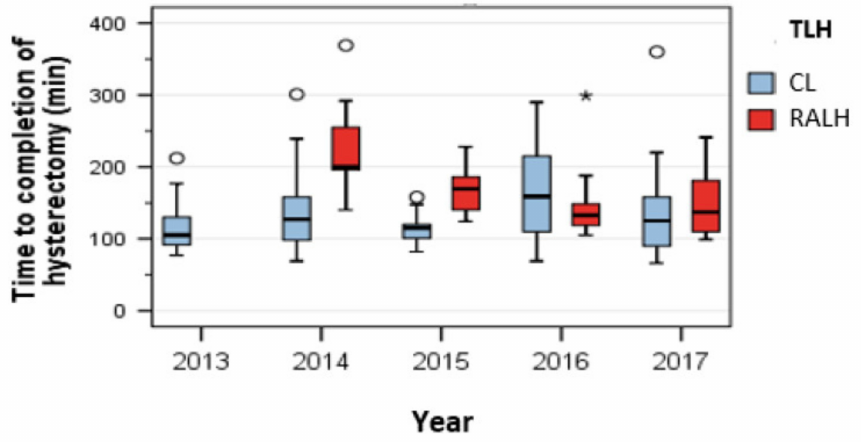
Figure 1. Operating times during the study: the shortest operating time for RALH was noted in 2016.